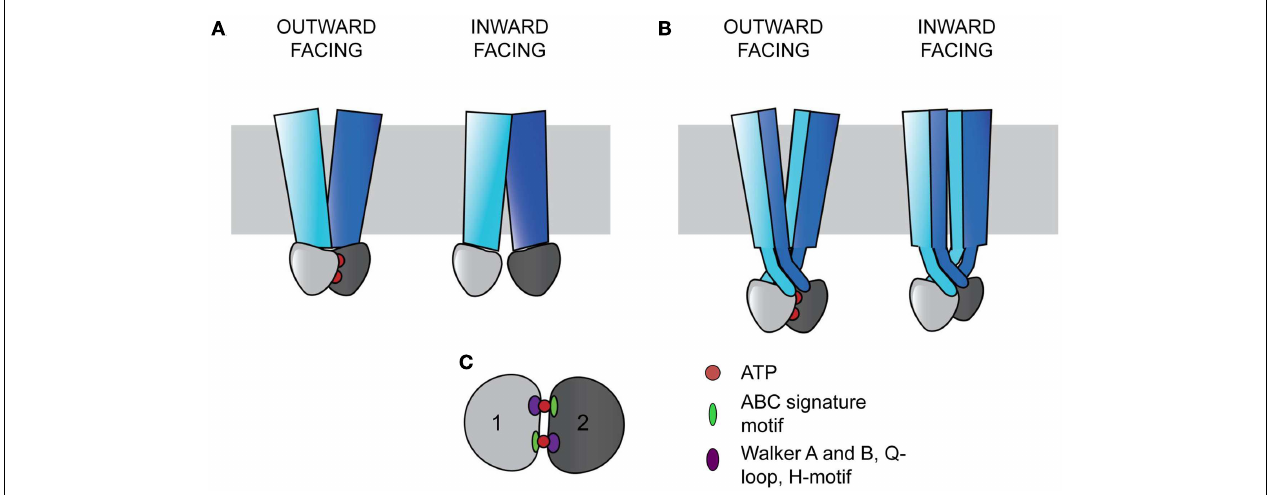
interacts with a single NBD (Examples include BtuCD and MalFGK). (B) In ABC exporters, theTMDs wrap around each other in a domain-swapped fashion, with eachTMD interacting with both NBDs (Examples include Sav1866 and MsbA). (C) The two NBDs sandwich two ATPs in a head-to-tail fashion. Each ATP binding and hydrolysis site is comprised of both NBDs, containing the conserved structural motifs in the catalytic subdomain including theWalker A and B, Q-loop, and H-motif (purple oval), and the ABC signature motif in the alpha-helical subdomain (green